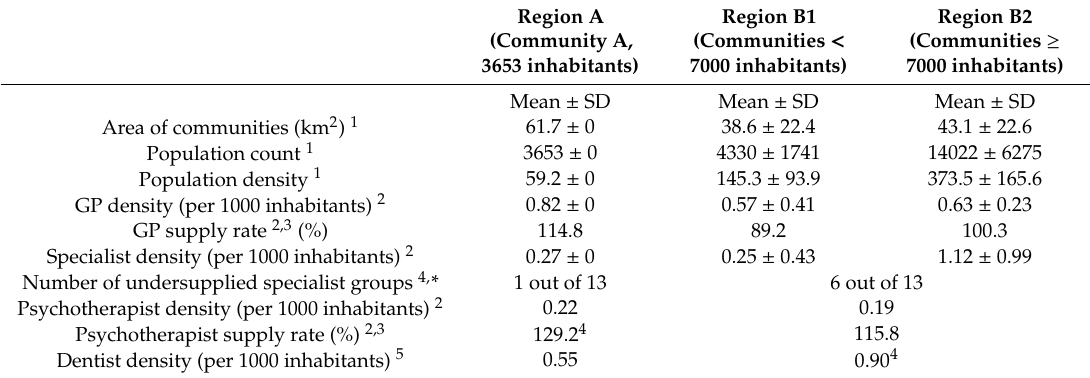
Table 1. Geographical and population characteristics of the study